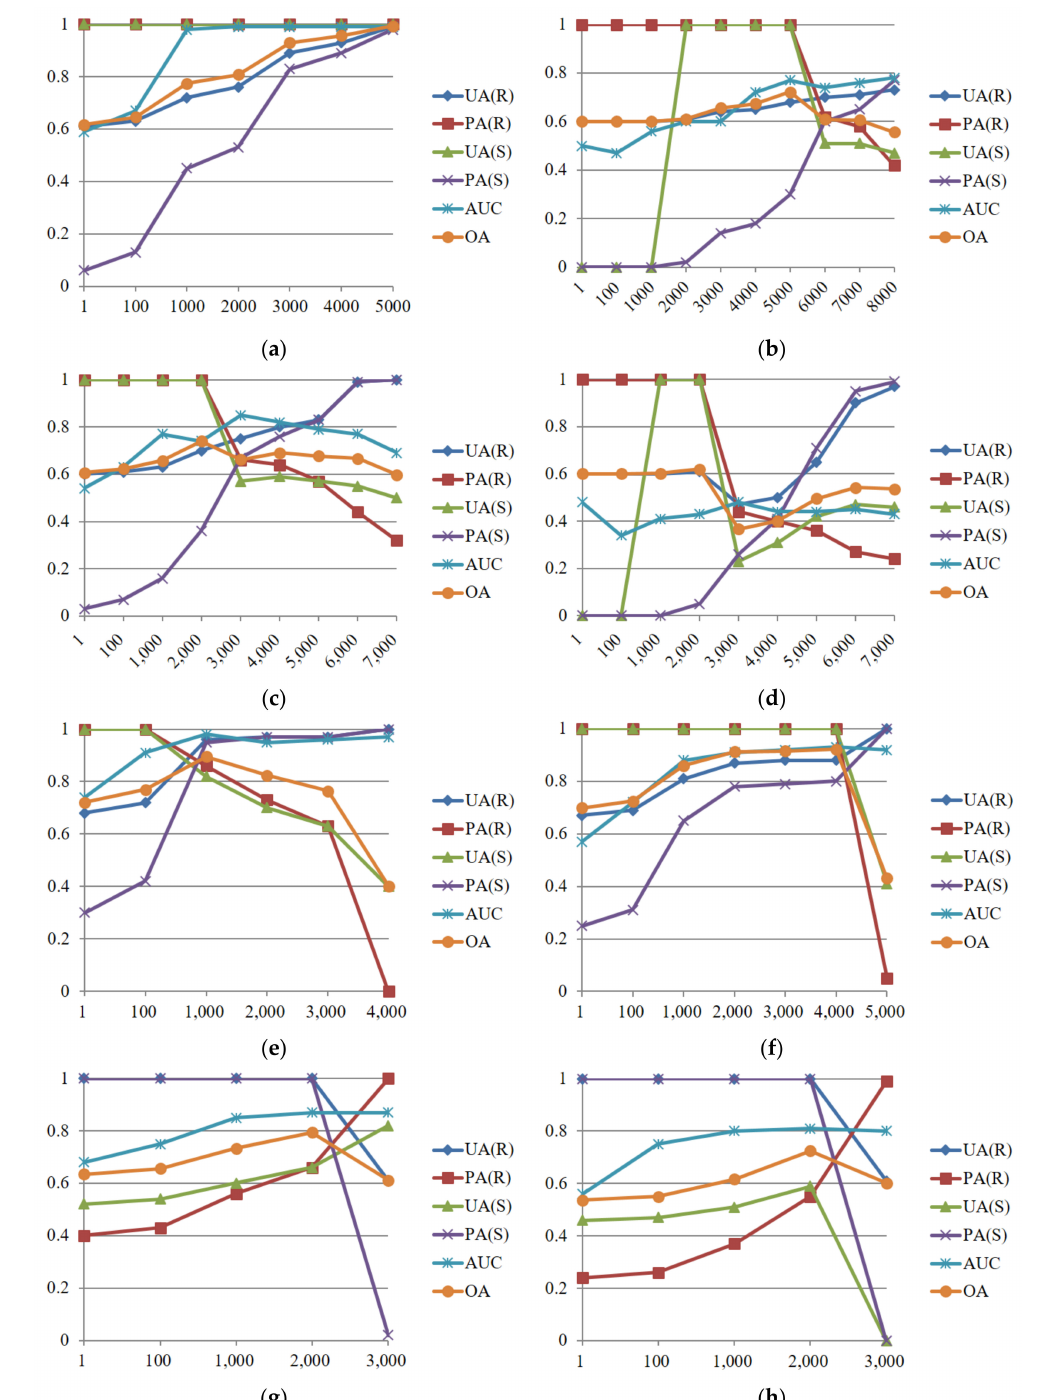
Figure 7. Accuracies ( Y -axis) of the RF-based models with di ff erent costs ( X -axis) and polygon samples for predictions, where OA, AUC, PA, UA, S, and R represent the overall accuracy, area under the ROC curve, producer’s accuracy, user’s accuracy, landslide source, and runout, respectively. ( a ) No. 1 model predicting No. 3 polygon samples, ( b ) No. 1 model predicting No. 5 polygon samples, ( c ) No. 2 model predicting No. 3 polygon samples, ( d ) No. 2 model predicting No. 5 polygon samples, ( e ) No. 3 model predicting No. 5 polygon samples, ( f ) No. 4 model predicting No. 5 polygon samples, ( g ) No. 5 model predicting No. 1 polygon samples, and ( h ) No. 5 model predicting No. 2 polygon